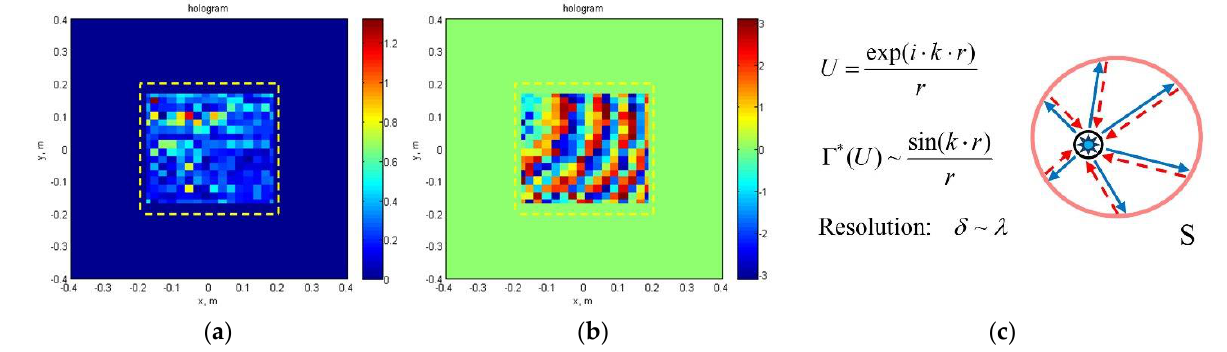
Figure 9. Amplitude ( a ) and phase ( b ) distribution of the scattered wave in the receiver antenna aperture and schematic picture of wave front conversion ( c ). Blue arrows symbolize outgoing spherical wave propagation, red ones — backward migration described with Equation (2).